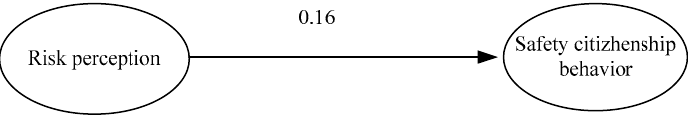
Figure 2. The results of model M1.